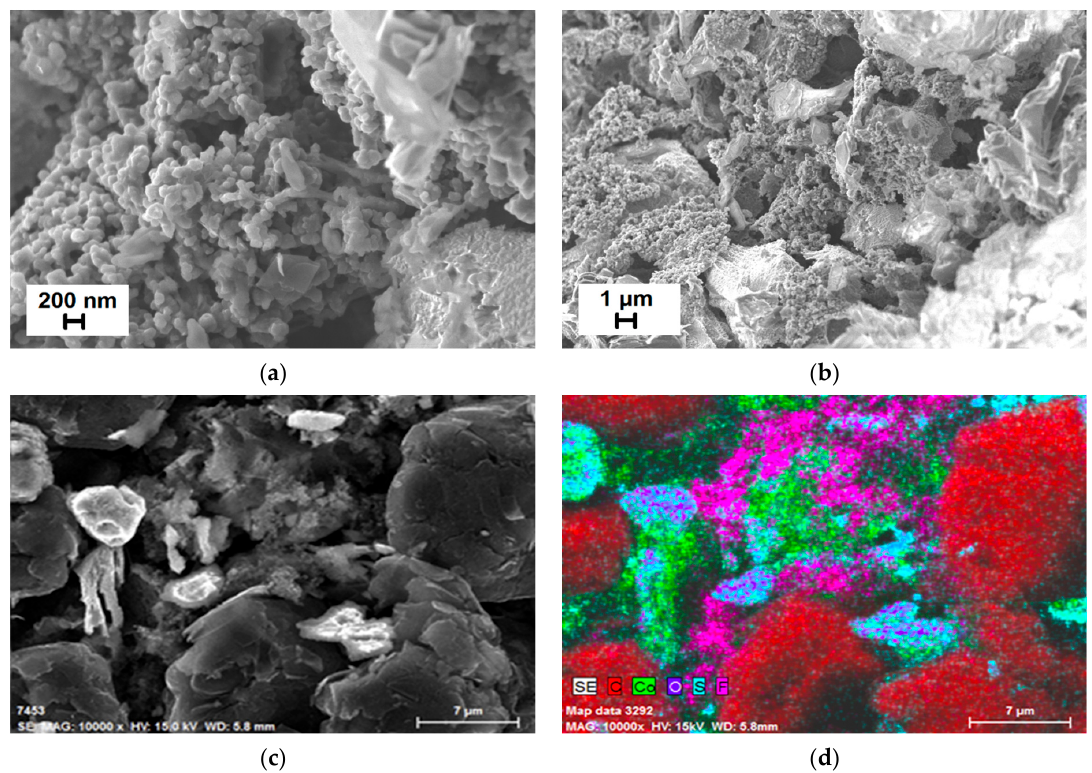
Figure 3. SEM images of sample 1, where ( a – c ) show different scales, while ( d ) is an EDS map of elements.